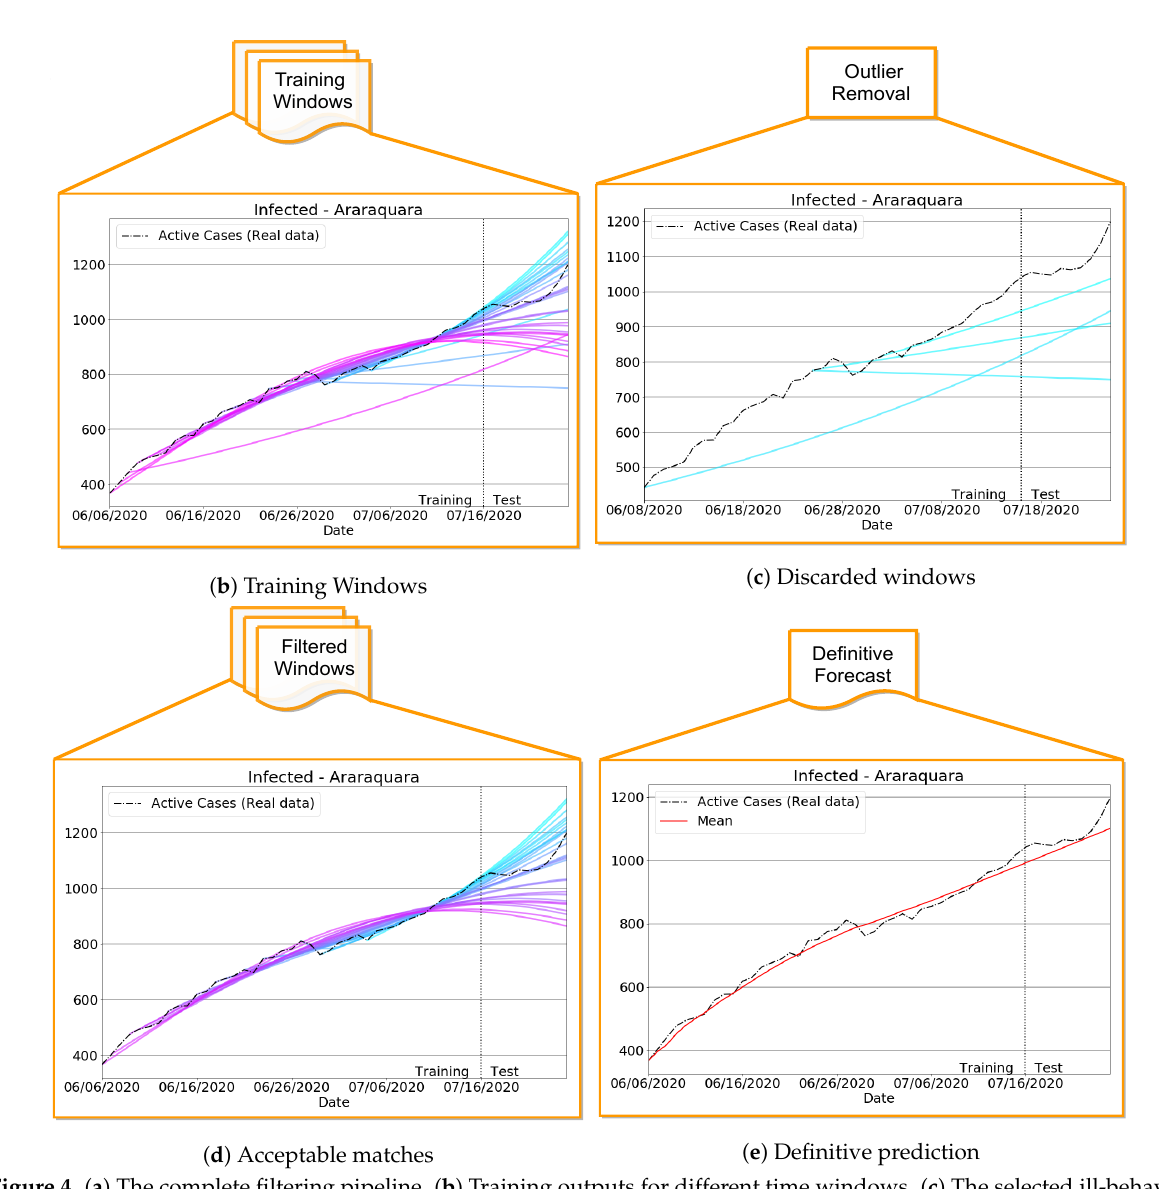
Figure 4. ( a ) The complete filtering pipeline. ( b ) Training outputs for different time windows. ( c ) The selected ill-behaved training periods (discarded trainings). ( d ) Training results that have passed the error criteria for good training. ( e ) Averaged results as the definitive